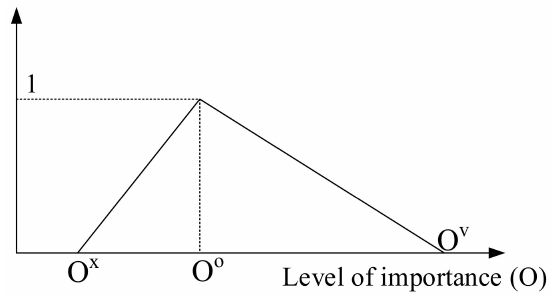
Figure 5. A triangular fuzzy number